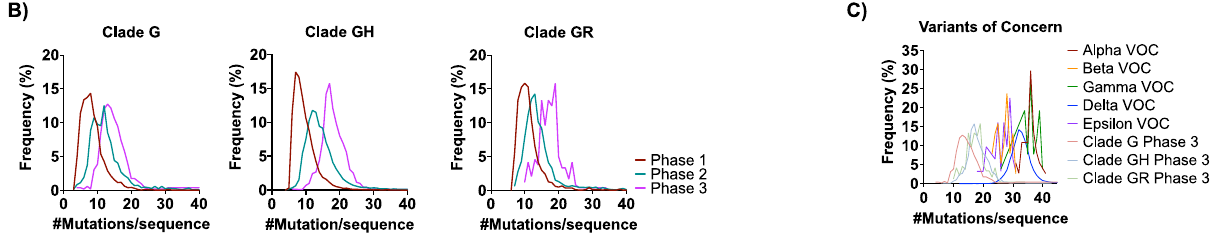
Figure 2. SARS-CoV-2 genetic diversity increased over time: ( A ) The number of sequences obtained from GISAID (https://www.gisaid.org/, accessed 17 December 2020) in the analysis for each clade by phase are reported. Genetic divergence was measured by panmixia probability [40] (significance cutoff, p < 10 − 3 ) for clade/Phase with >11 sequences for Phase 1 → 2 and Phase 2 → 3. Genetic diversity was measured by average pair-wise distance (%APD) and the percent of different SARS-CoV-2 variants. ( B ) The distribution of the frequency for the number of mutations per sequence relative to the Wuhan-Hu-1 isolate was determined for the G-based clades in each Phase. ( C ) Distribution of the frequency for the number of mutations per sequence for the VOCs: Alpha, Beta, Gamma, Delta, and Epsilon. The number of mutations/sequence (mut/seq) at the maximum peak frequency were: Clade G (13 mut/seq), Clade GH (17 mut/seq), Clade GR (19 mut/seq), Alpha VOC (36 mut/seq), Beta (28 mut/seq), Gamma (36 mut/seq), Delta (32 mut/seq), and Epsilon (29 mut/seq). ( # ND) Not enough sequences for proper analysis; (*) 2500 sequences were randomly selected for Panmixia, %APD, and %Different SARS-CoV-2 Variants.